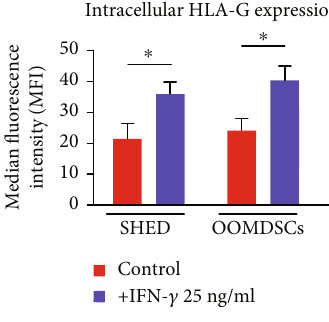
Figure 4: E ff ects of IFN- γ on the expression of immunogenic, costimulatory, and immunomodulatory molecules on the cell surface of SHED and OOMDSCs. (a, b) Neither SHED (a) nor OOMDSCs (b) expressed the costimulatory molecules CD40, CD80, and CD86 or the human leukocyte antigen class II HLA-DR on their cell surface, either in the absence of proin fl ammatory stimulation with IFN- γ or when stimulated with 25 ng/mL IFN- γ . (c) Higher expression of the human leukocyte antigen class I molecules HLA-A, HLA-B, and HLA-C was observed on the cell surface of both SHED and OOMDSCs treated with 25 ng/mL IFN- γ than on that of MSCs that were not treated with IFN- γ . However, this increase in the MFI value was statistically signi fi cant only when the OOMDSCs were treated with 25 ng/mL IFN- γ . (d) After treatment with 25ng/mL IFN- γ , the expression of the immunomodulatory molecule HLA-G by both OOMDSCs and SHED was higher than that in the corresponding control-treated cells. This increase in the MFI value was statistically signi fi cant for both the SHED and the OOMDSCs treated with25ng/mLIFN- γ .(e,f)Thee ff ectsofIFN- γ onthecellsurfaceandintracellularexpressionofHLA-Gwereassessed.(e)CellsurfaceHLA-G expression remained unchanged in SHED treated with 25 ng/mL IFN- γ but increased in OOMDSCs treated with 25ng/mL IFN- γ ; however, this increase was not statistically signi fi cant. (f) Intracellular HLA-G expression increased signi fi cantly in both SHED and OOMDSCs treated with 25 ng/mL IFN- γ . Histograms demonstrate the binding of conjugated antibodies (in red) and isotype controls (in blue) to antigens. ∗ p < 0 : 05 , determined by an unpaired Student t -test. Five experimental replicates were performed for each group for both SHED and